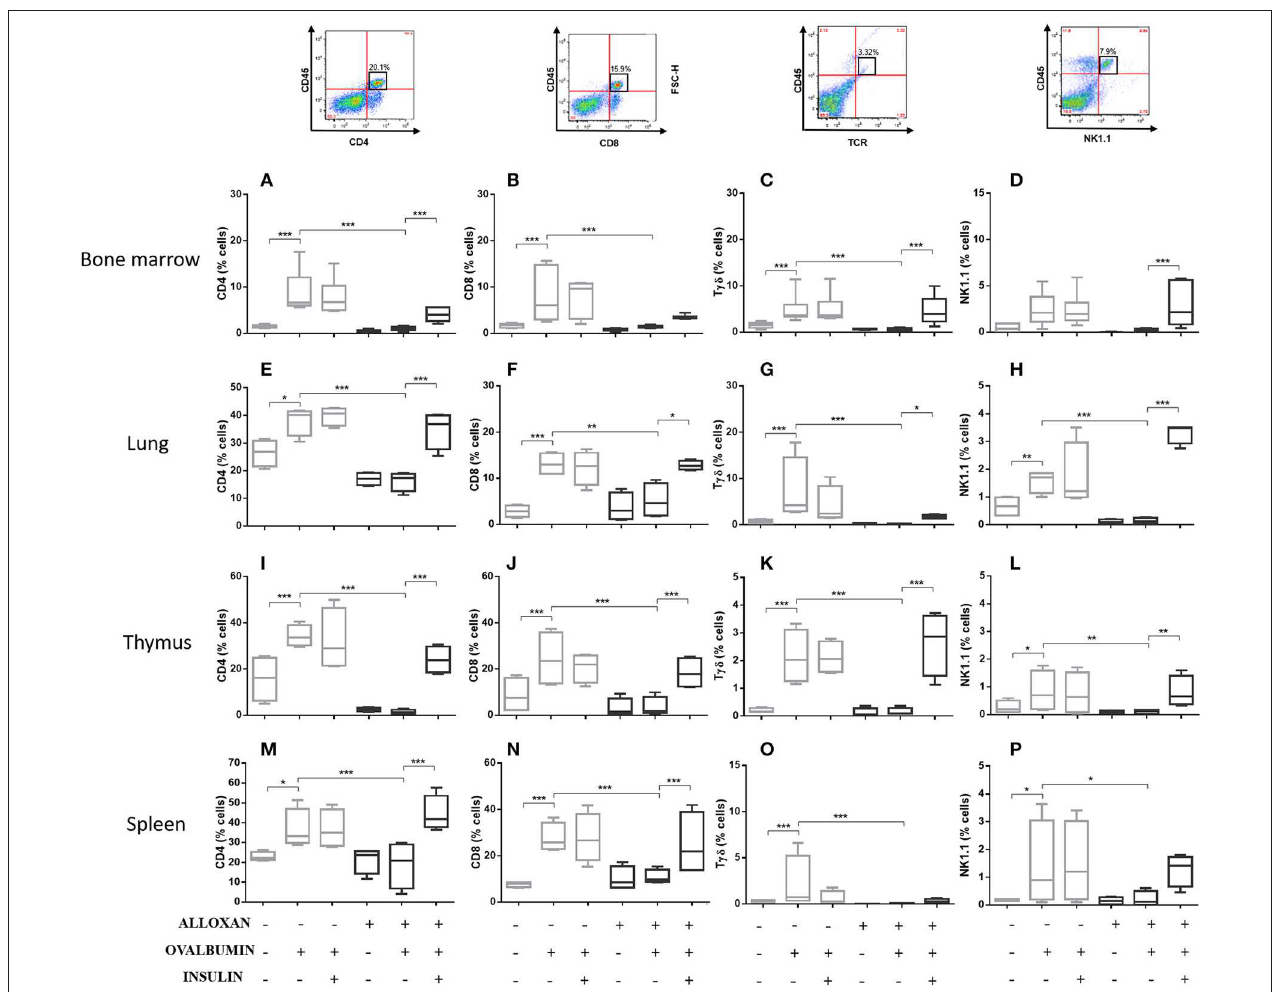
FIGURE 4 | Profile analysis of recruited T lymphocytes and NK cells. Acquisitions were performed using an FACSCanto flow cytometer, and the data were analyzed using FlowJo software (Tree Star, Inc., USA). We analyzed 20,000 events. Representative dot plots showing the gating strategy used to identify T cells and NK cells in the bone marrow, (A) CD4, (B) CD8, (C) T γδ , and (D) NK1.1; lung, (E) CD4, (F) CD8, (G) T γδ , and (H) NK1.1; thymus, (I) CD4, (J) CD8, (K) T γδ , and (L) NK1.1; and spleen, (M) CD4, (N) CD8, (O) T γδ , and (P) NK1.1. Values represent the mean ± SEM from three independent experiments. * p < 0.05; ** p < 0.01; *** p < 0.001. The groups were tested with two-way analysis of variance followed by Tukey–Kramer post-hoc tests (GraphPad Prism version 6.0 for Windows, GraphPad Software, La Jolla, CA,